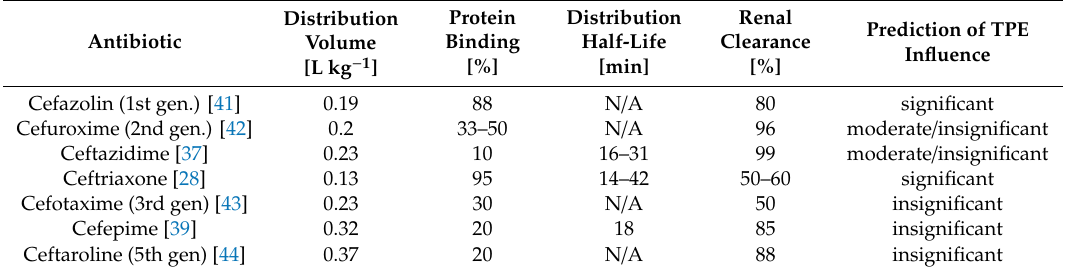
Table 2. TPE and